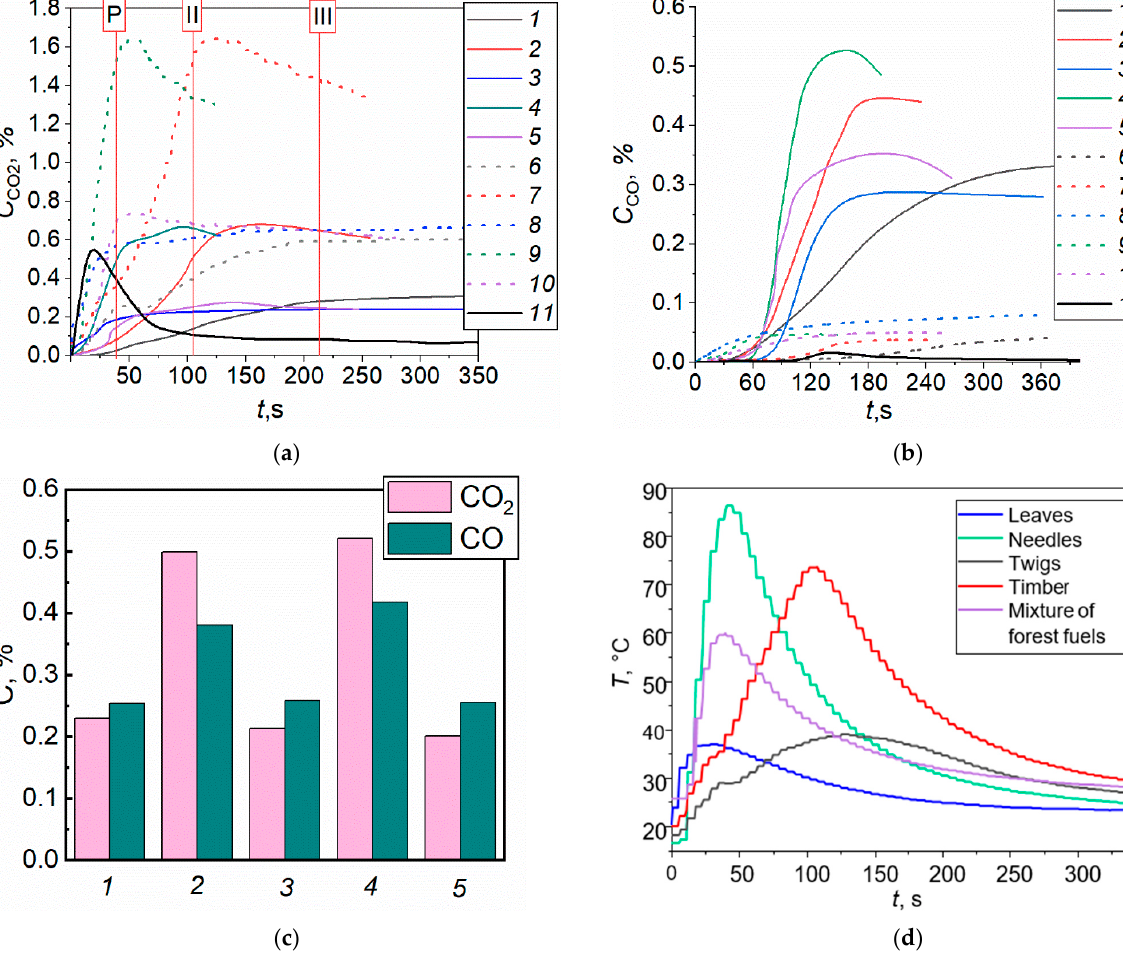
Figure 3. Trends of CO 2 ( a ) and CO ( b ) recorded during the combustion of typical forest fuels: 1,6— twigs; 2,7 —timber; 3,8— leaves; 4,9— needles; and 5,10— mixture of forest fuels. 1 – 5 —concentrations of CO and CO 2 measured with a laboratory gas analyzer; 6 – 10 —concentrations of CO and CO 2